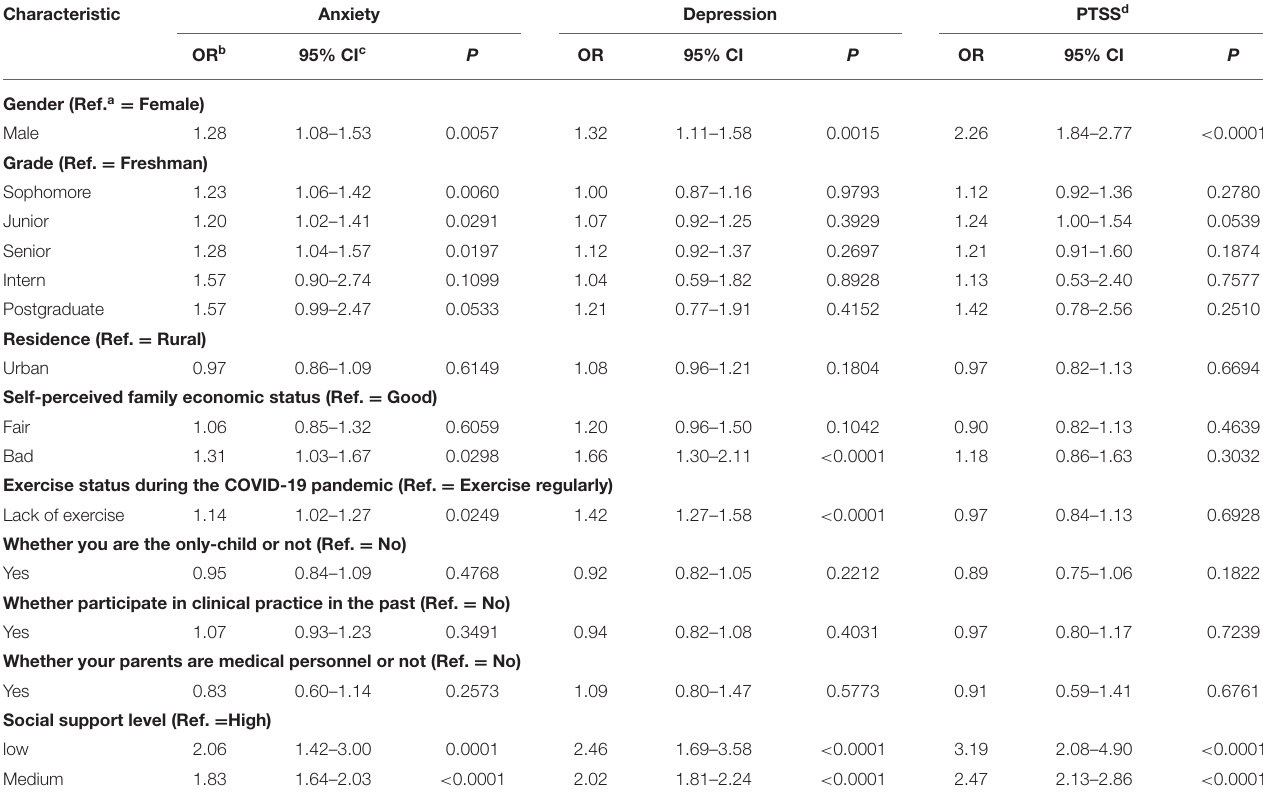
TABLE 4 | Multivariate logistic regression analysis of factors associated with anxiety, depression and PTSS among nursing students. Characteristic Anxiety Depression PTSS d OR b 95% CI c P OR 95% CI P OR 95% CI P